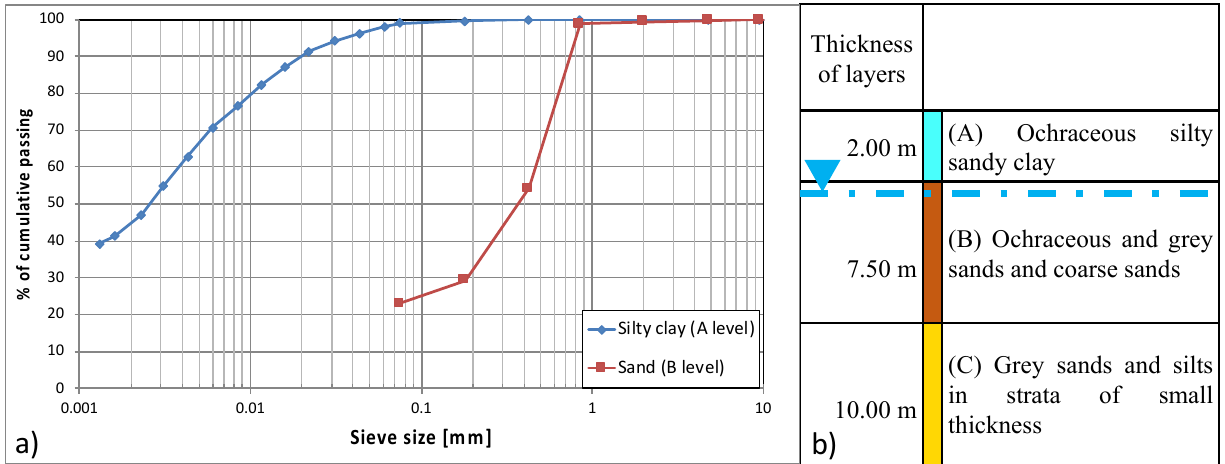
Figure 2. ( a ) Grain size distributions of silty and sandy components. ( b ) General stratigraphy of the Metaponto aquifer, the dash-dot blue line represents the piezometric level of the aquifer.